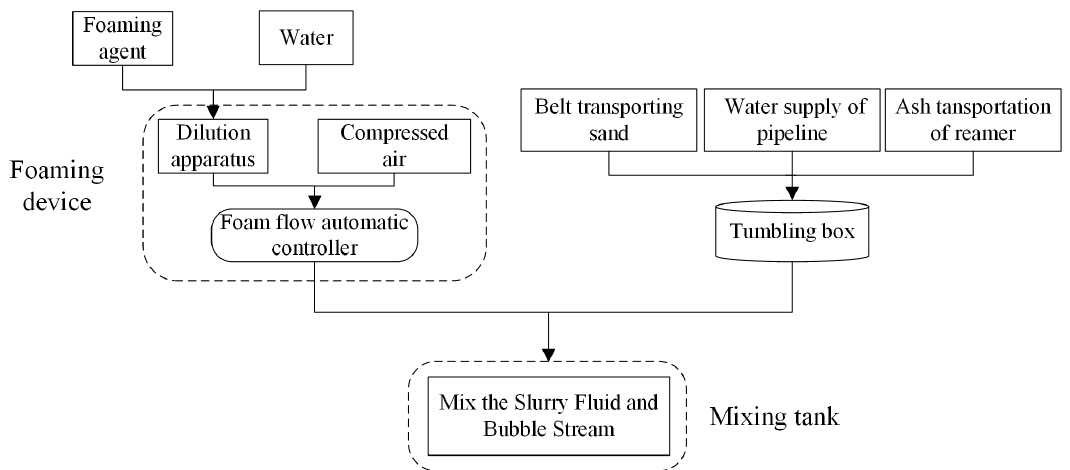
Figure 1. Manufacturing processes for foam slurry.